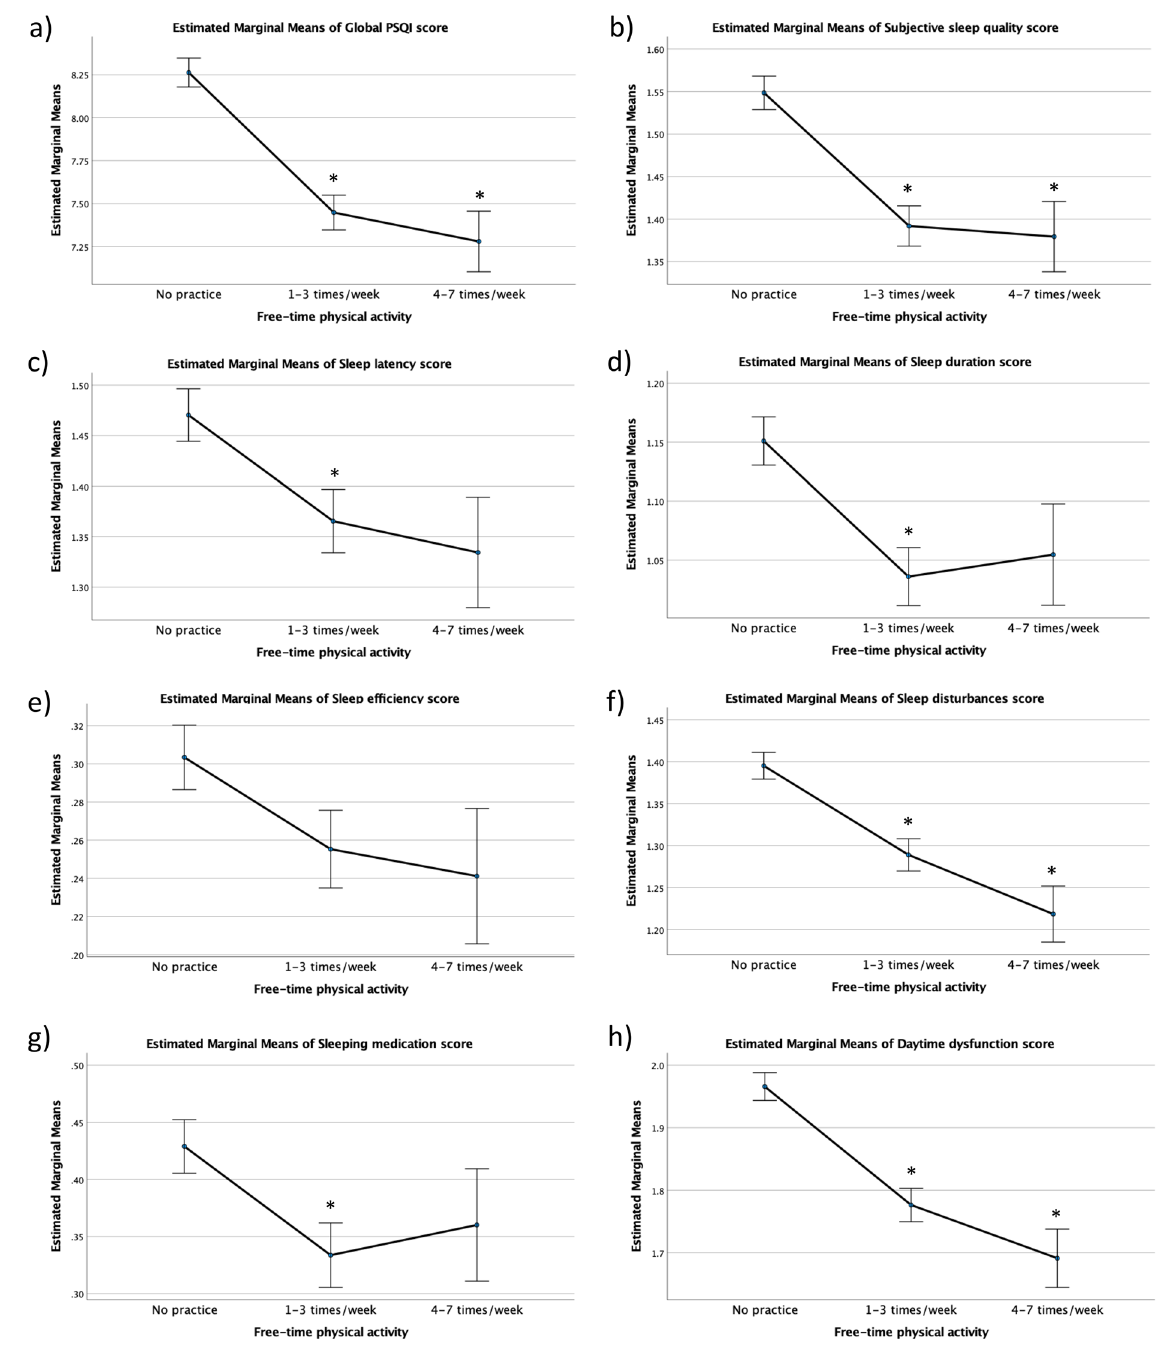
Figure 1. Raw estimated marginal means of the Pittsburgh Sleep Quality Index score and its components by frequency of free-time physical activity in Brazilian university students. Values were obtained with unadjusted ANCOVA